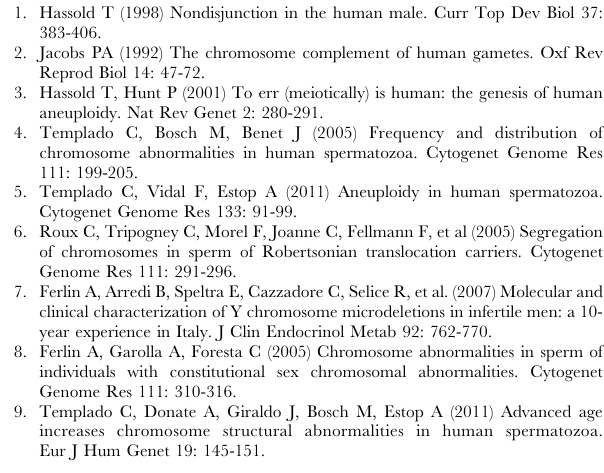
Table S1 Conditions of sperm DNA decondensation